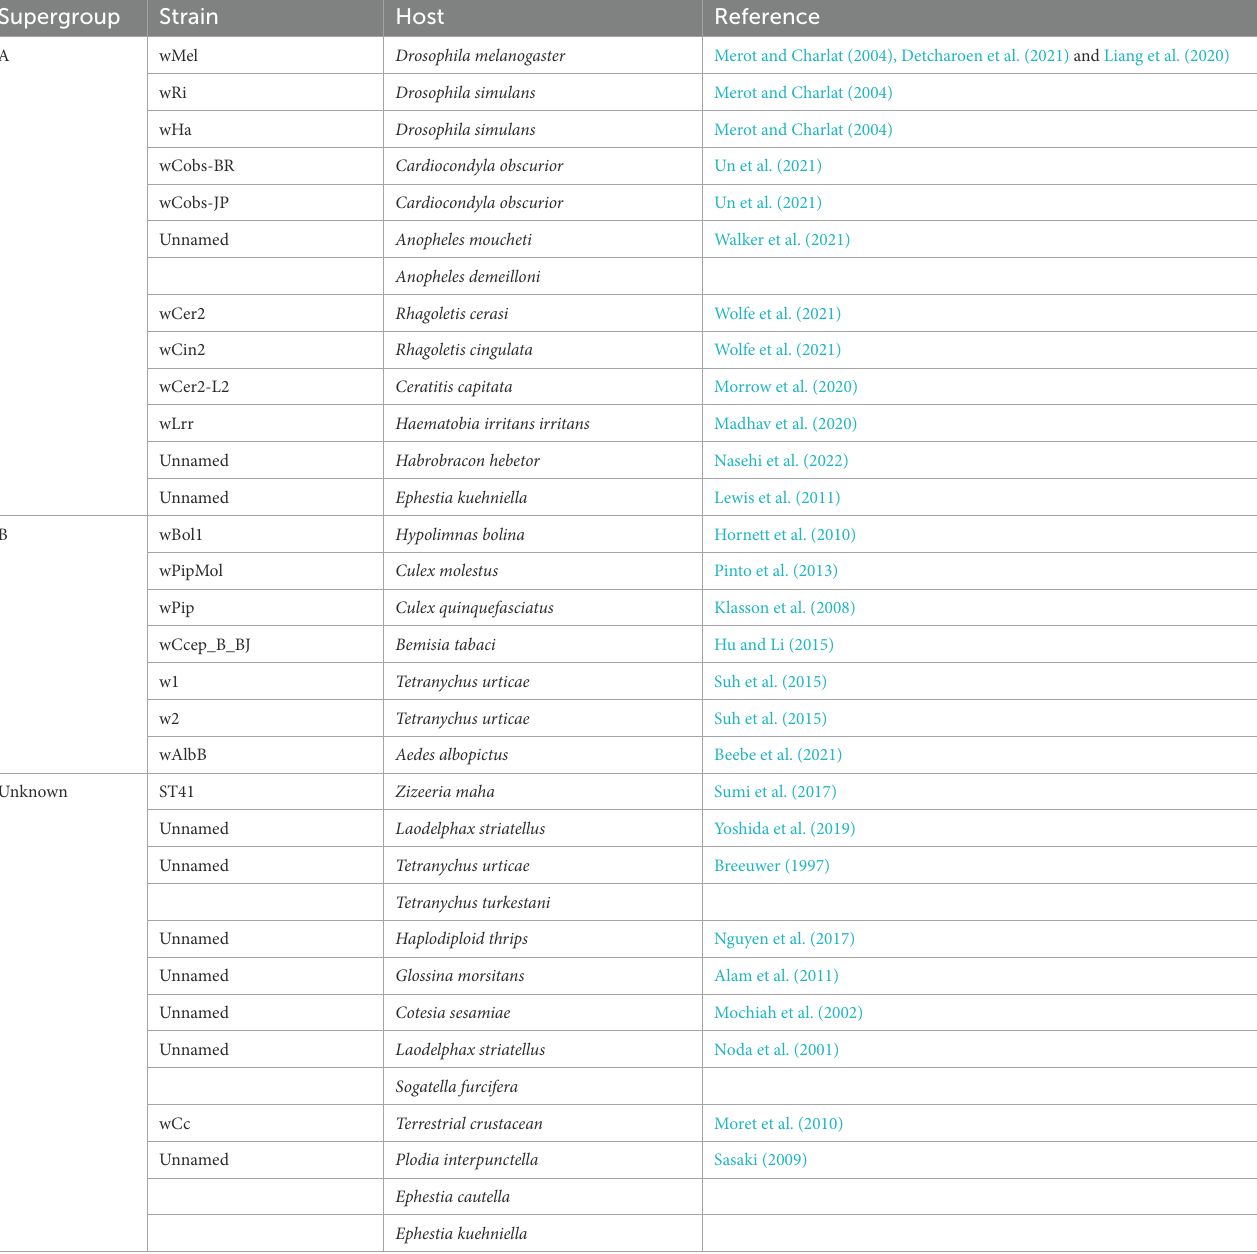
TABLE 1 Information of CI-inducing Wolbachia strains.